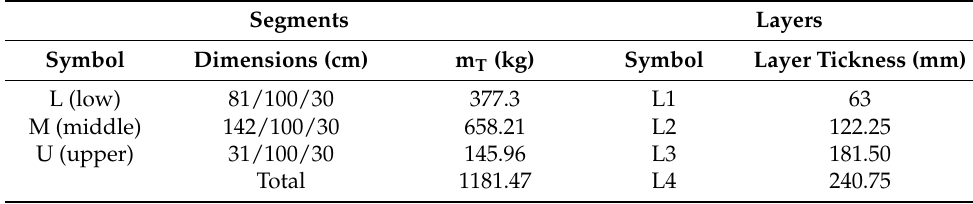
Table 2. Details of sandy material build-up in the slope